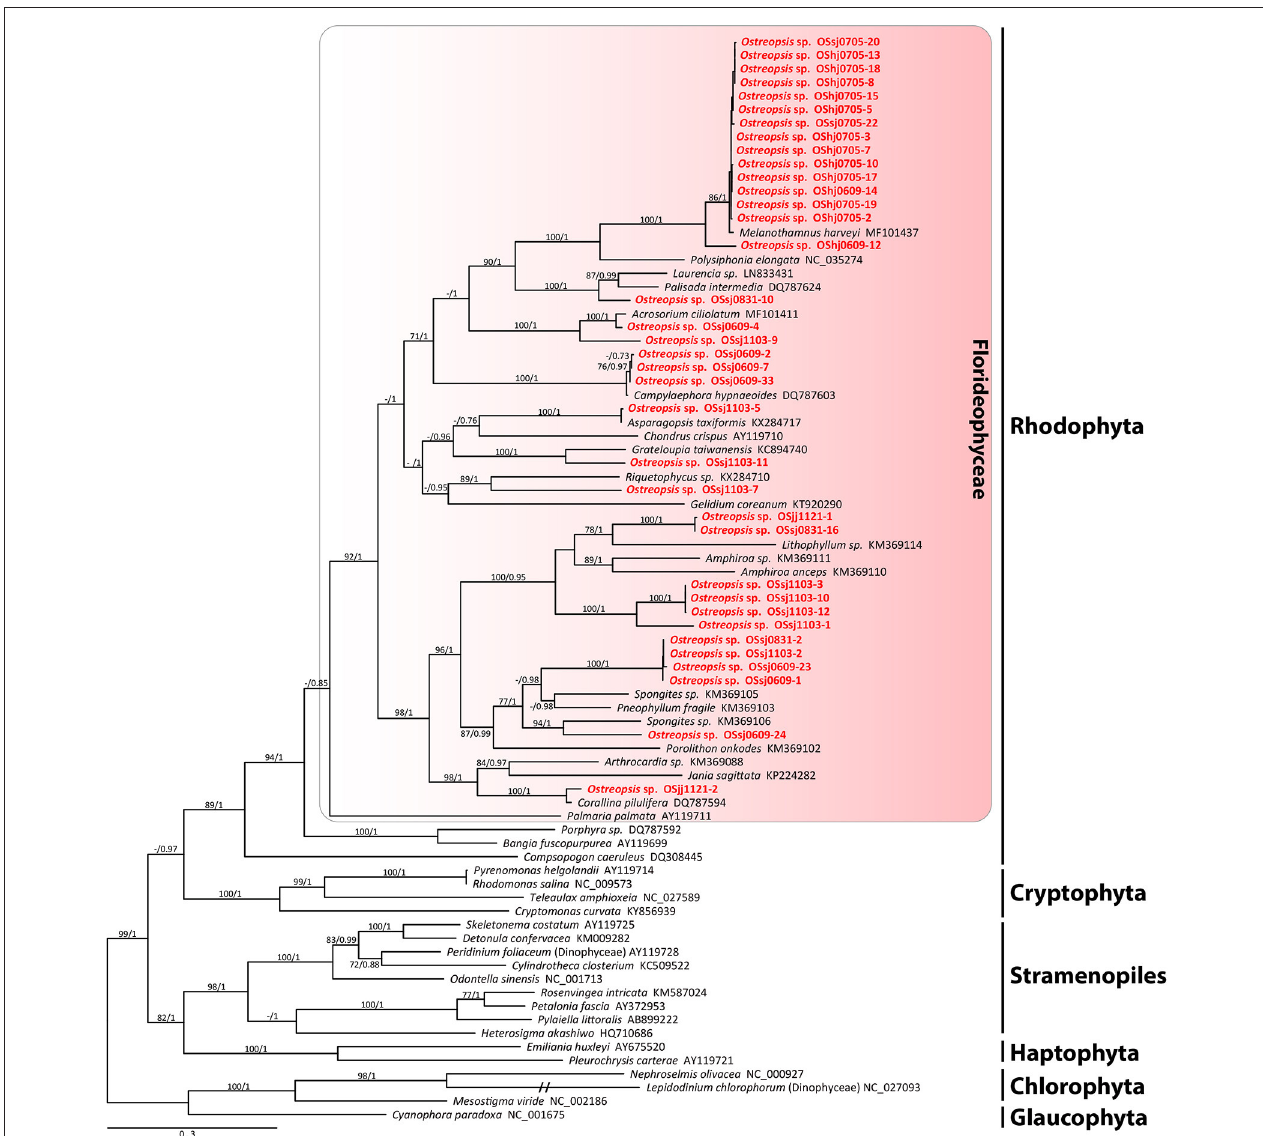
FIGURE 7 | RAxML tree inferred from psa A sequences of 2,200 sites and representing 80 taxa including Rhodophyta, Cryptophyta, Stramenopiles, Haptophyta, Chlorophyta, and Glaucophyta. Sequences from the ingested food particles of Ostreopsis cells isolated from this study are indicated in bold face. Bootstrap value ( > 70%) from maximum likelihood and a Bayesian posterior probability of 0.7 or greater are indicated at nodes. Double slash marks indicate shrink nodes length